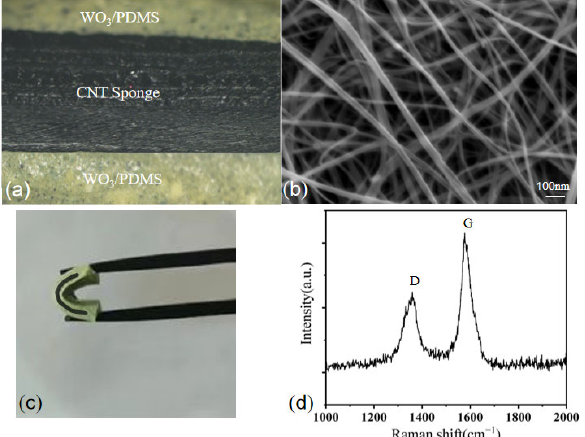
Figure 2. The CNT sponge/PDMS/WO 3 force-sensitive structure: ( a ) cross-sectional view; ( b ) SEM image; ( c ) flexible display of physical objects; ( d ) Raman diagram of the CNT sponge.